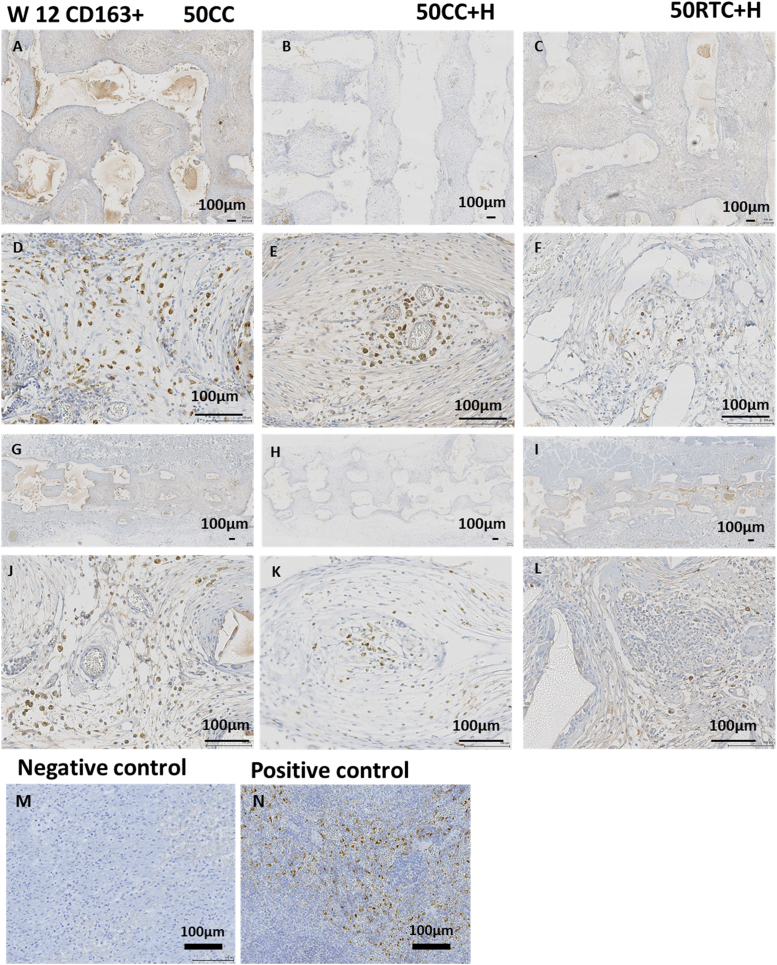
Immunohistochemistry of the host macrophage response towards scaffolds in vivo at weeks 12. Tissue integration of middle-in-plane (A-F) and cross-sectional view (G-L) of the scaffolds by CD163 (M2 macrophage marker) staining at (A-C, G-I) ×4 and (D-F, J-L) ×20 magnifications. (M) Negative control (rat appendix); (N) positive control (rat liver). Scale bar: 100 μm.